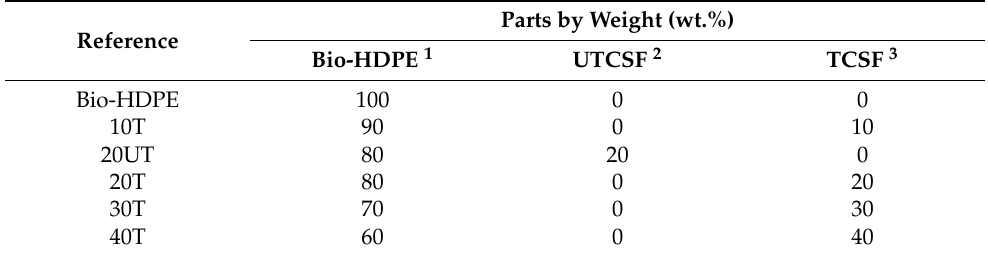
Parts by Weight